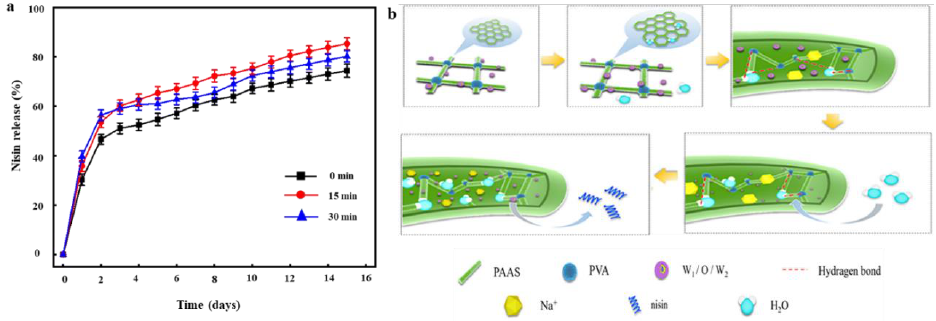
Figure 5. ( a ) The release of nisin from EN and PVA/PAAS/EN-15% nanofibers under different ultrasound times; ( b ) the release behavior of nisin from polyvinyl alcohol/polyacrylate sodium